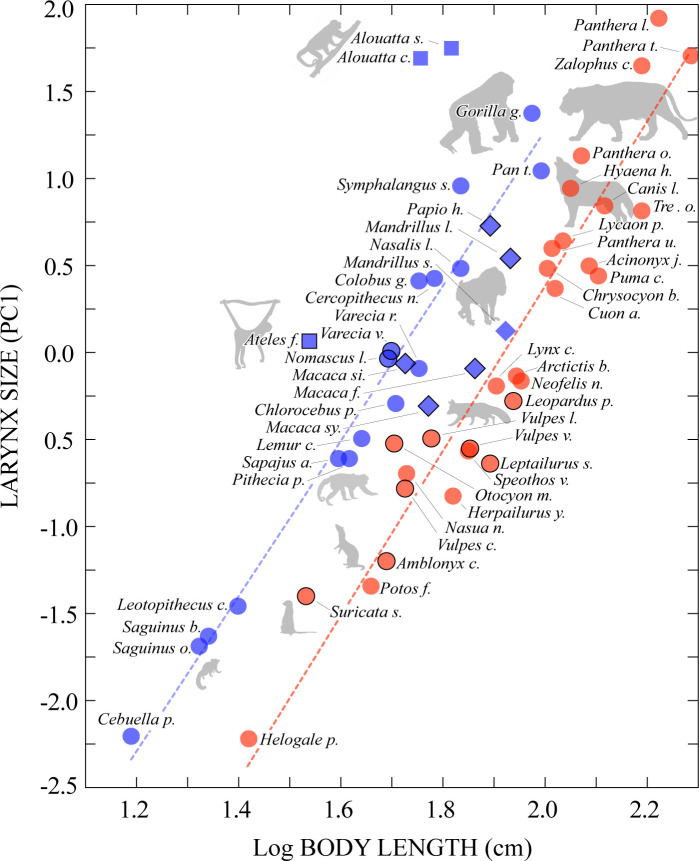
Body length versus larynx size.Base 10 logarithm of body length plotted against the PC1 of the larynx measurements for our sample of 26 primate (blue) and 29 carnivoran (red) specimens. Squares depict atelids and diamonds depict papionines, clades that stand out for having exceptionally large or small larynges among primates, respectively (see text). Specimens belonging to one of the eight pairs used to estimate the magnitude of the grade shift between primates and carnivorans are outlined in black. Regression lines display a significant grade shift between primates and carnivorans, as quantified by pANCOVA (see text). See Fig 3 for full species names corresponding to the abbreviated names shown here. The data used to create this figure are located in S1 Data, sheet B, columns B and C. pANCOVA, phylogenetic ANCOVA; PC1, first principal component.